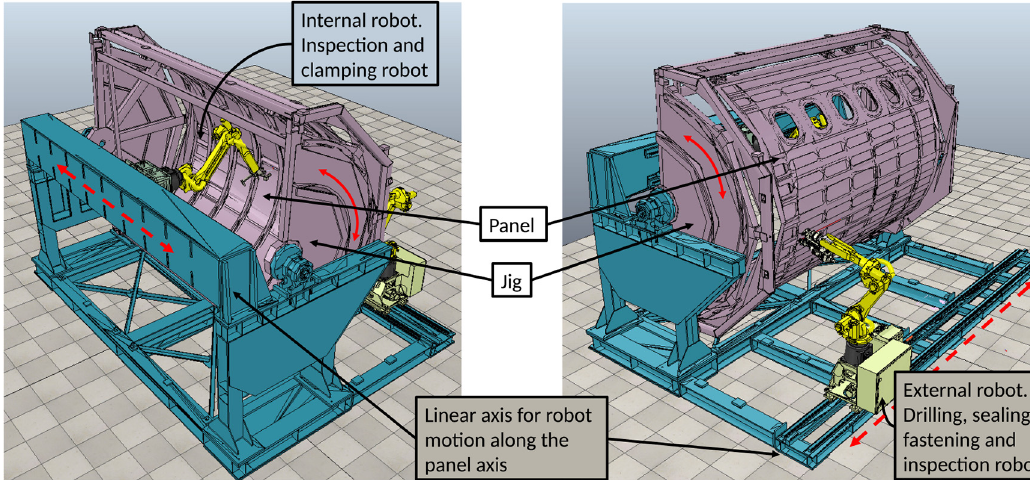
Fig. 1. LABOR cell represented in the